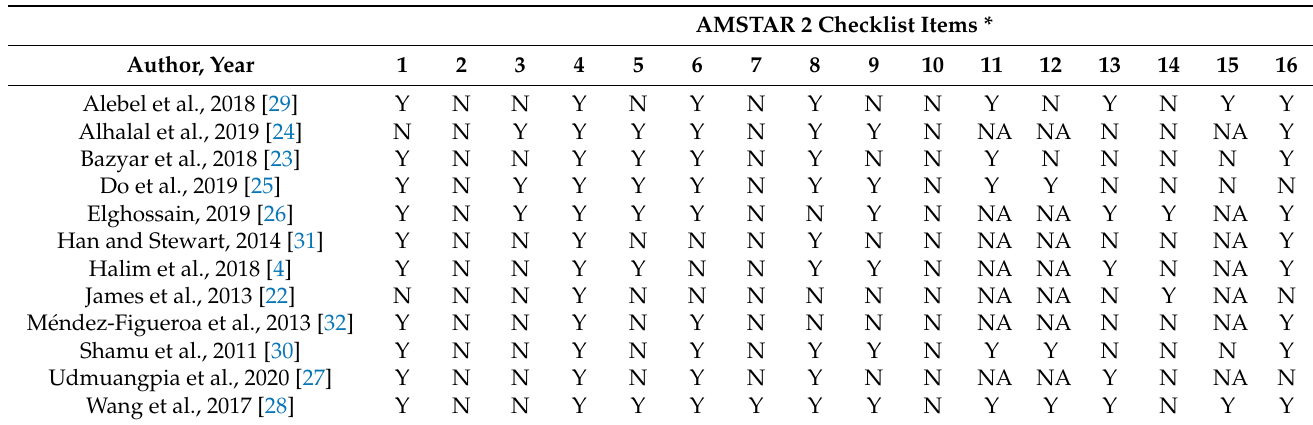
Table 3. Evaluation of selected IPV during pregnancy reviews based on AMSTAR 2